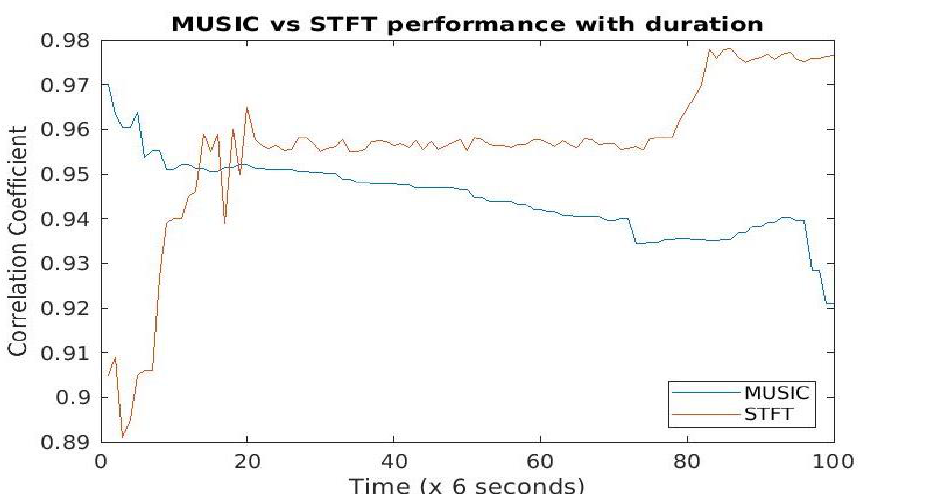
Figure 3. Performance of STFT and MUSIC spectrum estimation methods on ENF estimation based on the length of input signal.